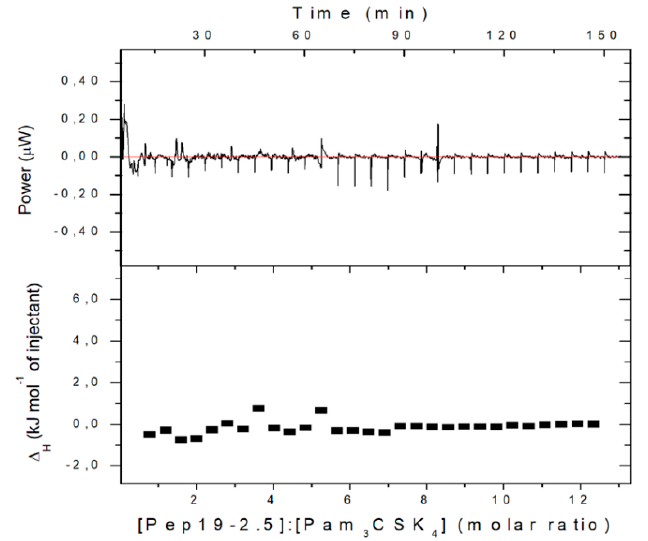
Figure 15. Binding study of Pep19-2.5 with Pam 3 CSK 4i . The peptide (1 mM) was titrated in 5 µ L portions to a 0.05 mM solution of Pam 3 CSK 4 and the respective enthalpy change was recorded.